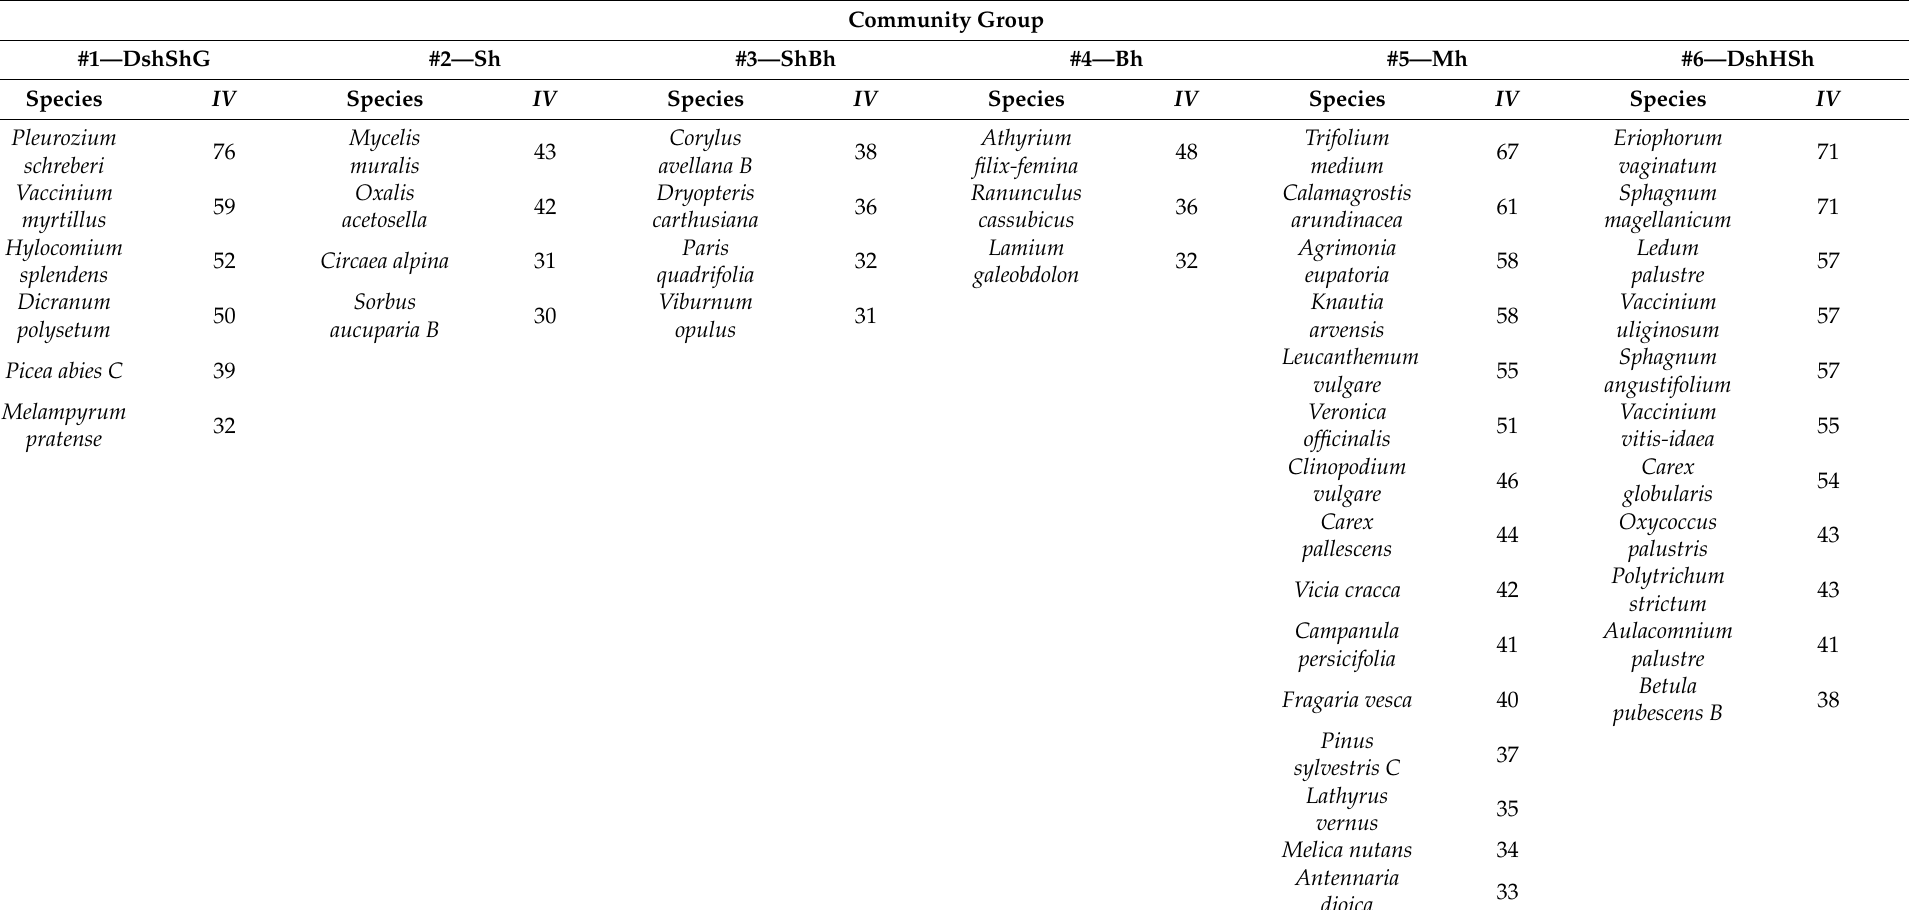
Table A3. Indicator values (IV) for species in community groups of pine and pine-spruce forests. Community